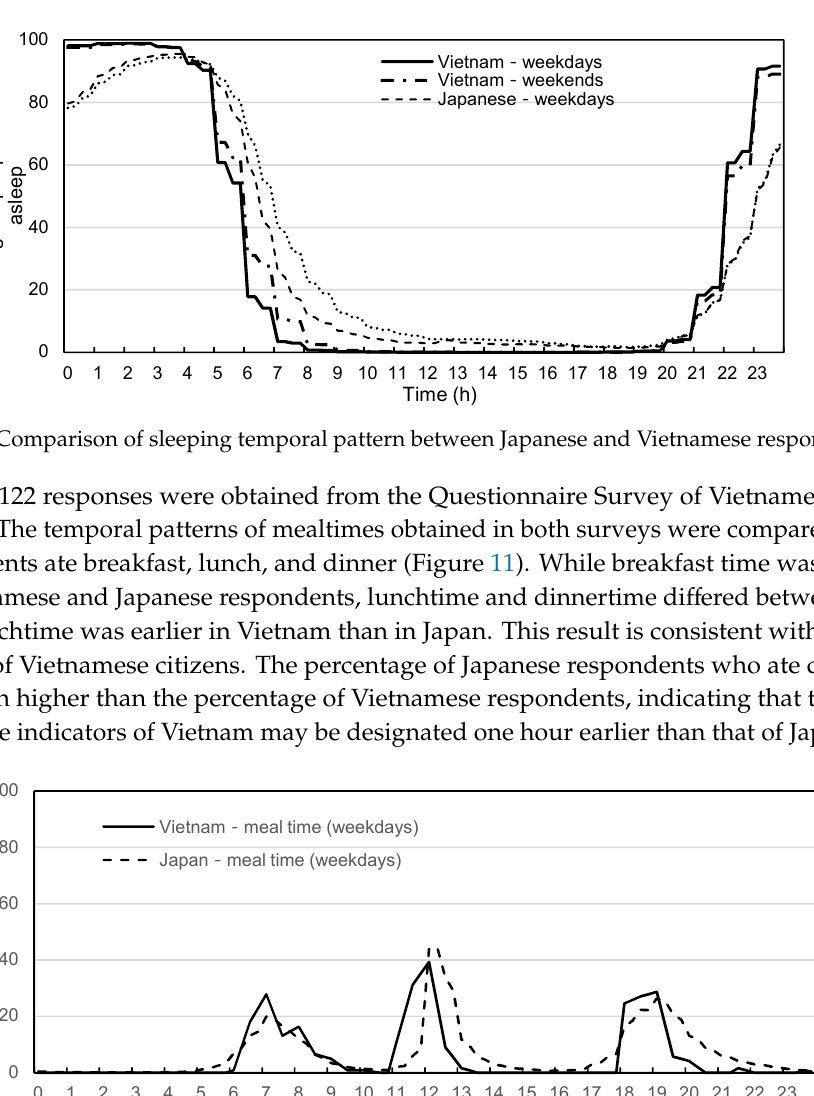
Figure 9. Comparison of sleeping time between the 2009 and 2017 surveys conducted at Noi Bai airport. 3.6. Comparison of Temporal Pattern of Daily Activities between Japanese and Vietnamese People